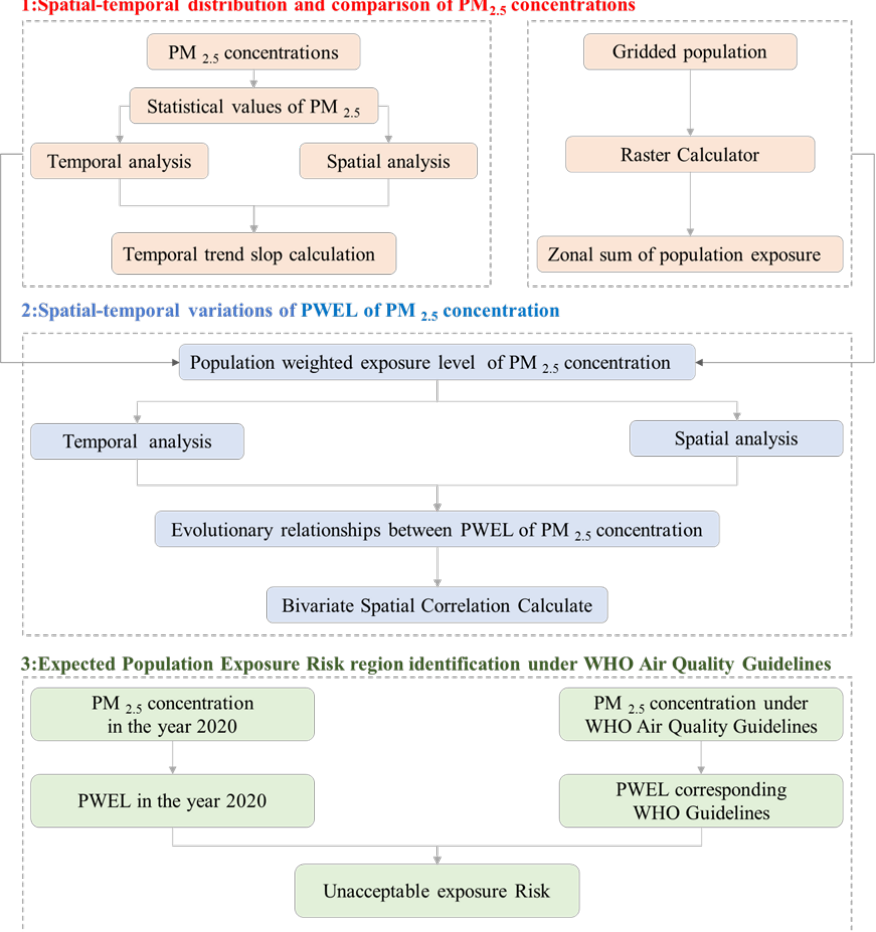
Figure 2. The technical flowchart of this study.